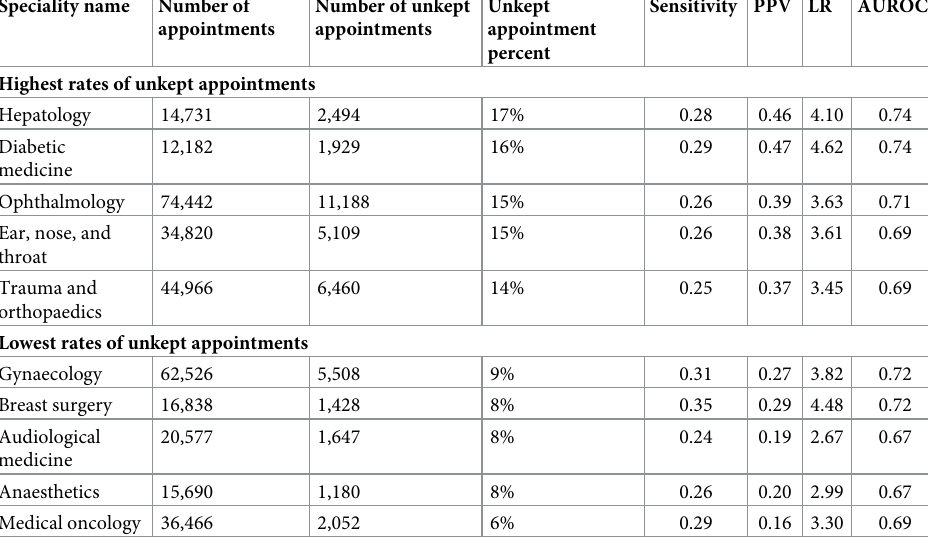
Table 6. Gradient boosting machine validation metrics of specialties with the highest and lowest unkept appoint- ment